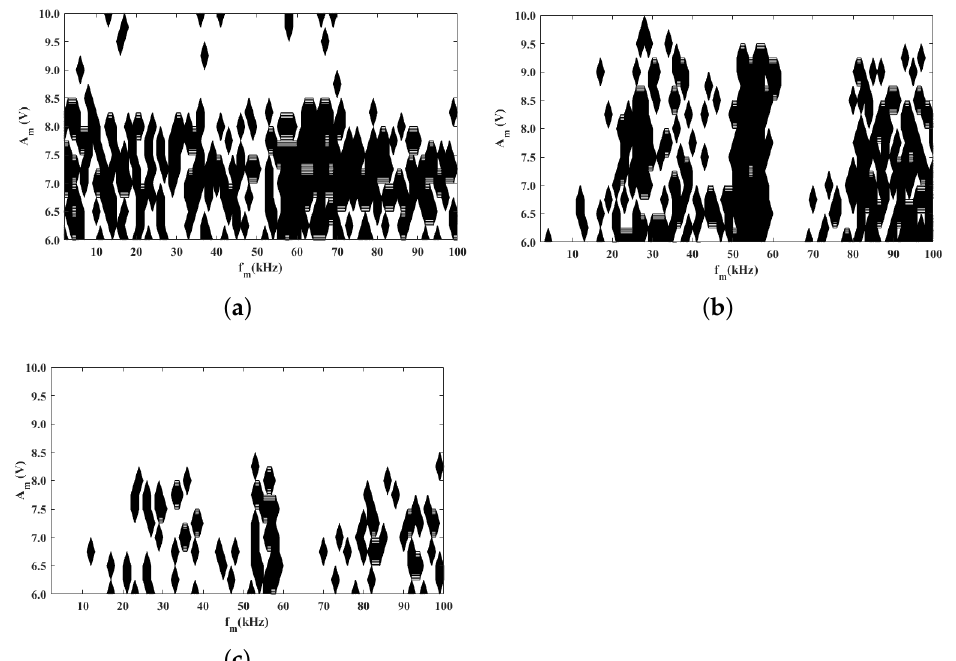
Figure 11. Stability zones for different amplitudes A m and frequencies f m . ( a ) represents the standard deviation of the local maxima, ( b ) represents the standard deviation of the interspike-interval (ISI), and ( c ) represents the values of the parameters for which there are minimums of standard deviation of the ISI and of the local maxima of the emission at 532